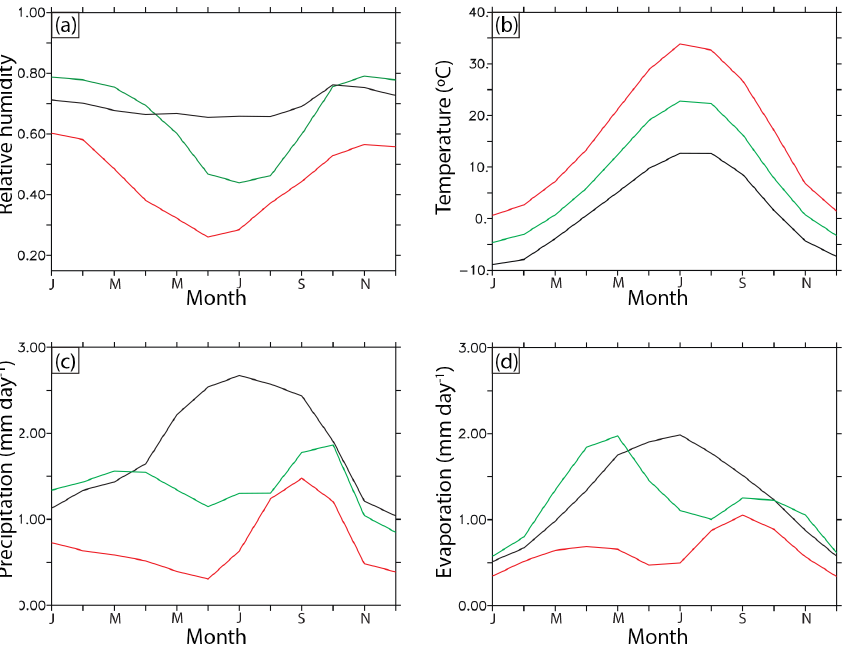
Figure 7. Intra-annual variations in (a) low level relative humidity, (b) near-surface temperature, (c) precipitation amount and (d) evaporation amount. All variables are averaged for TP with the altitude over 1500m. Black colour corresponds to MOD experiment, green – for INT experiment and red – for LOW